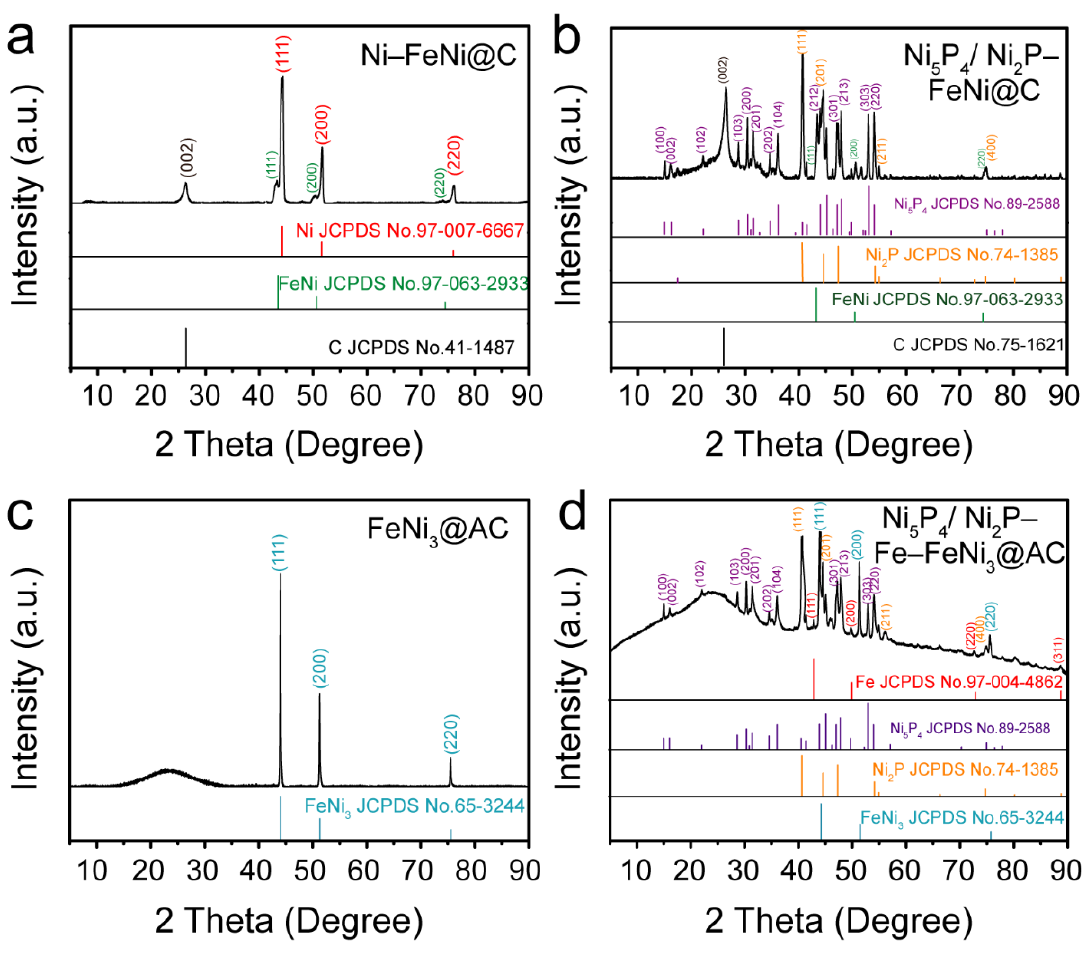
Figure 2. XRD patterns of ( a ) Ni–FeNi@C, ( b ) Ni 5 P 4 /Ni 2 P–FeNi@C, ( c ) FeNi 3 @AC and ( d ) Ni 5 P 4 /Ni 2 P–Fe–FeNi 3 @AC samples.